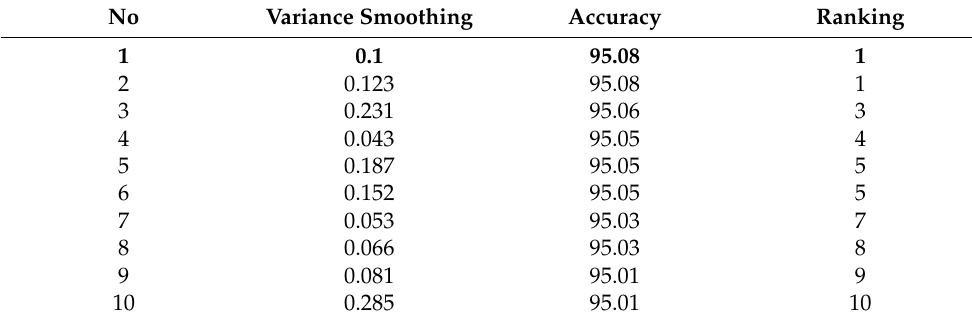
Table 10. Naïve Bayes algorithm hyperparameter optimization results.